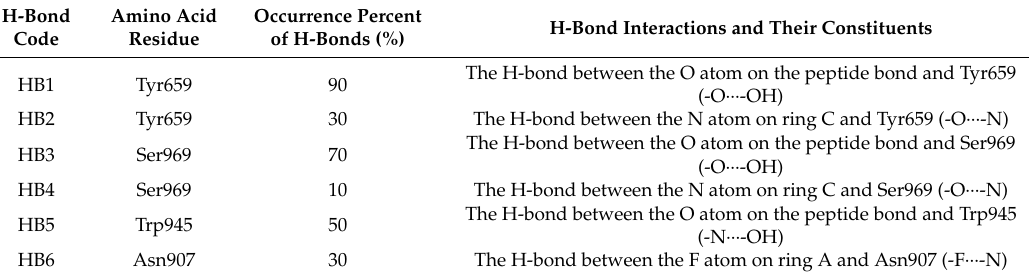
Figure 7. All the binding interactions observed in the last 10 ns MD simulation. Amino acid residues in the active site are represented as sticks; the molecular carbon and the amino acid residue carbon are represented by green and yellow, respectively. The N, O, S, F, and Cl atoms are represented by dark blue, red, orange, cyan, and dark green, respectively. The H-bond and the π – π stacking interactions are represented as blue and purple dashed lines, respectively. Table 2. The H-bond interactions in MD simulation results within the last 10